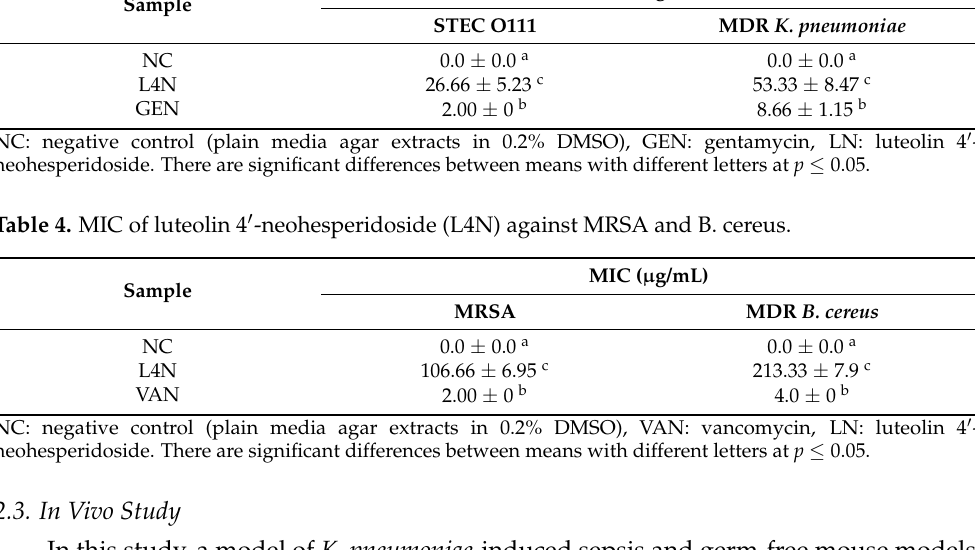
Figure 4. Immunoglobulin M (IgM, ng/mL) levels in the model of mice infected with MDR K. pneumoniae ( A ) and E. coli STEC O111 ( B ) and then treated with luteolin 4 ′‐ neohesperidoside (L4N) and gentamycin (GEN). a Significant difference from normal control group at p < 0.05. b Significant difference from infected group at p < 0.05. ab Significant difference from normal control group and infected group at p < 0.05. The lungs of the K. pneumoniae (Figure 5a–c) ‐ positive control mice showed dilated pulmonary blood vessels and focal hemorrhages in the interstitial tissue, as well as the alveolar lamina. Inflammatory infiltrate composed of histiocytes and polymorphonuclear cells was also detected. On the other hand, lungs of the mice infected with K. pneumoniae and then treated with Luteolin showed moderate infiltration of inflammatory cells, and emphysema of the pulmonary alveoli were observed. Lungs of the mice infected with K.